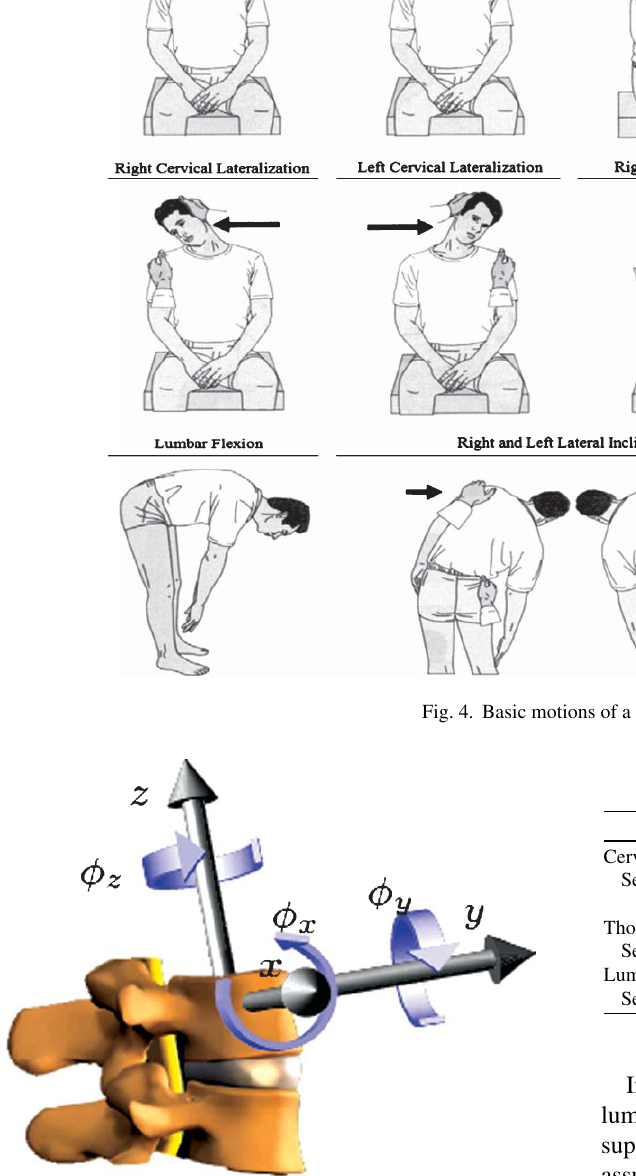
Fig. 5. Reference axes and rotations for motion of a